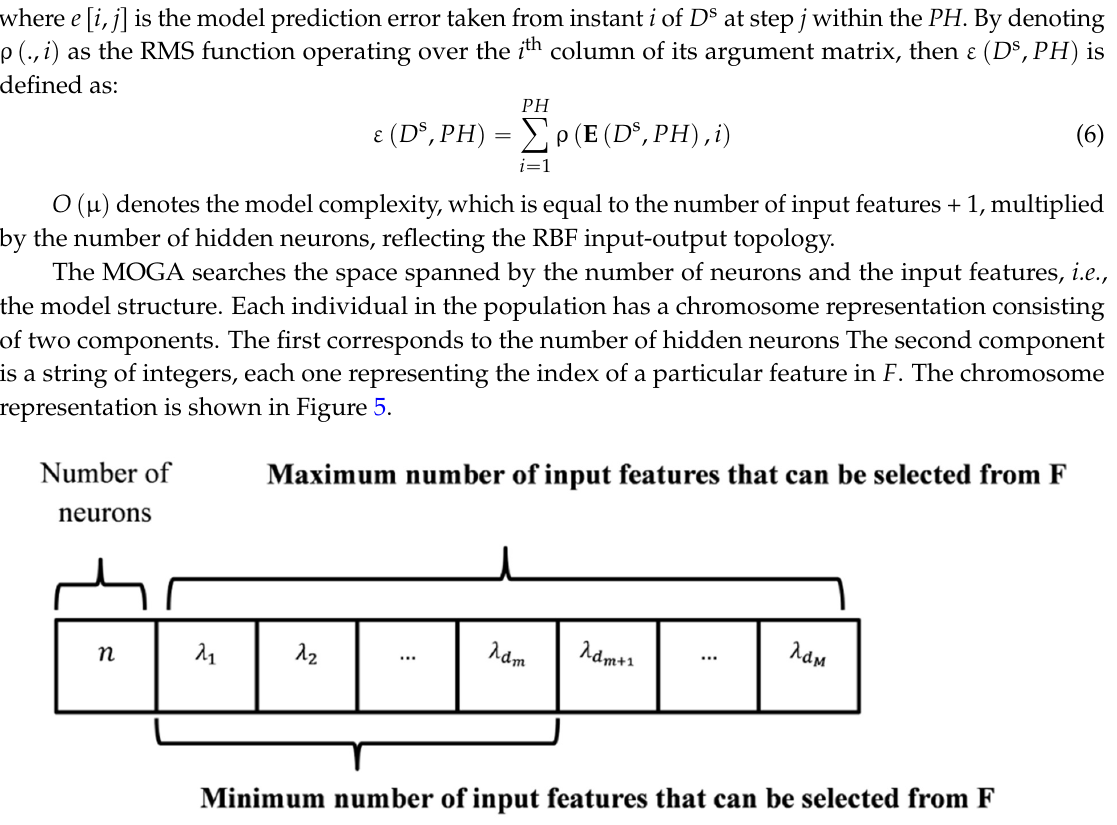
Figure 5. Chromosome representation.